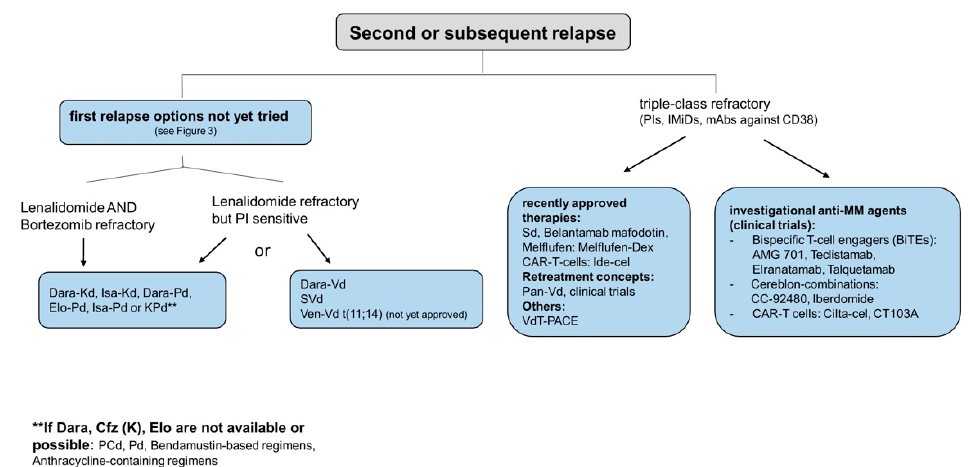
Figure 5. Treatment algorithm for RMM—2nd or subsequent relapse. After the establishment of a